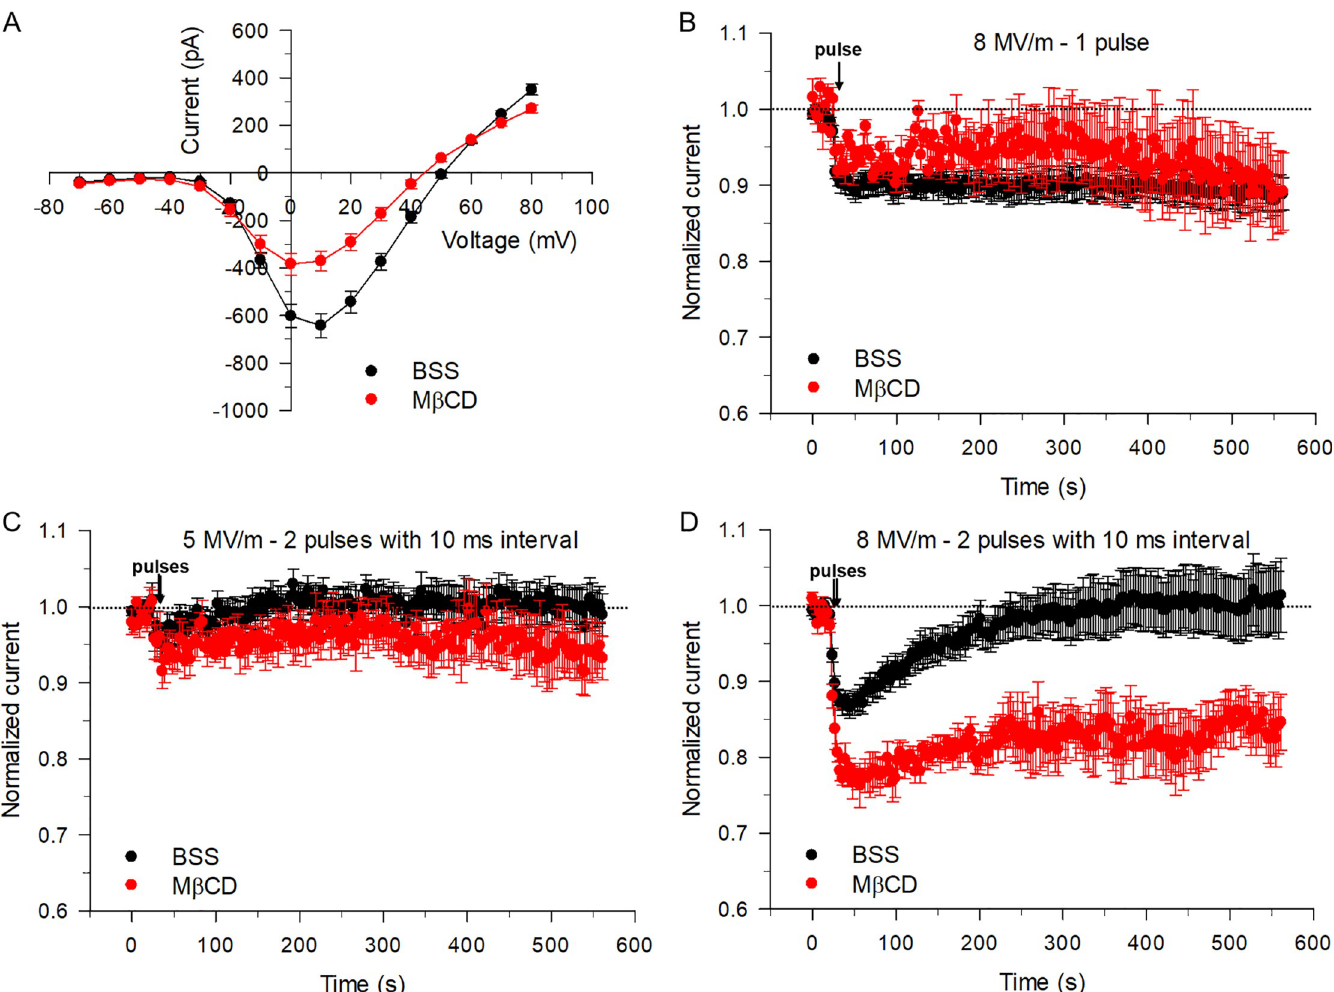
Fig 9. Disruption of lipid rafts reduces I Na and alters the impact of twin NEPs on the inward current. (A) The voltage step protocol to construct the I-V relationship of peak I Na was described in the Methods. The mean I-V relationships were obtained either in the presence of normal BSS (black circles) or in BSS containing M β CD (red circles). (B) Time course of changes in I Na for cells exposed to a single pulse at an E-field of 8 MV/m recorded in the absence (black circles) or presence (red circles) of M β CD. (C) Time course of changes in I Na for cells exposed to twin NEPs at an E-field of 5 MV/m with a 10 ms time interval between the pulses recorded in the absence (black circles) or presence (red circles) of M β CD. (D) Time course of changes in I Na for cells exposed to twin pulses at an E-field of 8 MV/m with a 10 ms time interval between the pulses recorded in the absence (black circles) or presence (red circles) M β CD. Cells exposed to M β CD were pre-incubated with the drug at a concentration of 3 mg/ml for a minimum of 30 min. Data are expressed as the mean ± SE. (A): BSS, n = 16; M β CD, n = 14; (B): BSS, n = 15; M β CD, n = 6; (C): BSS, n = 9; M β CD, n = 5; (D): BSS, n = 10; M β CD, n =